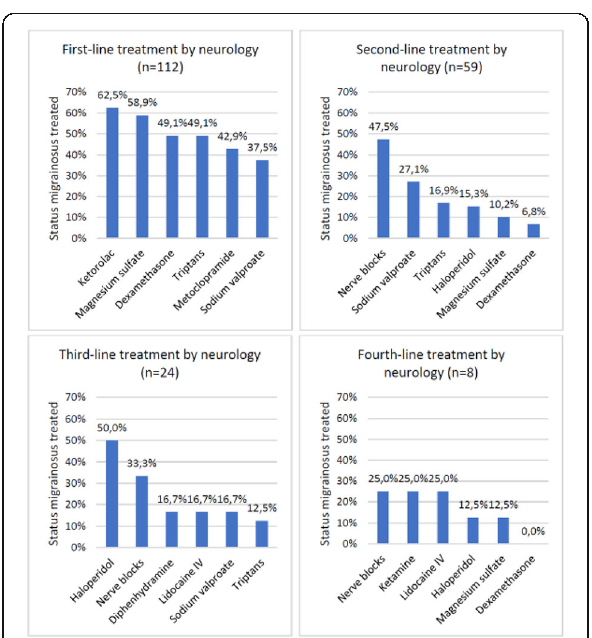
Fig. 2 (abstract P38). See text for